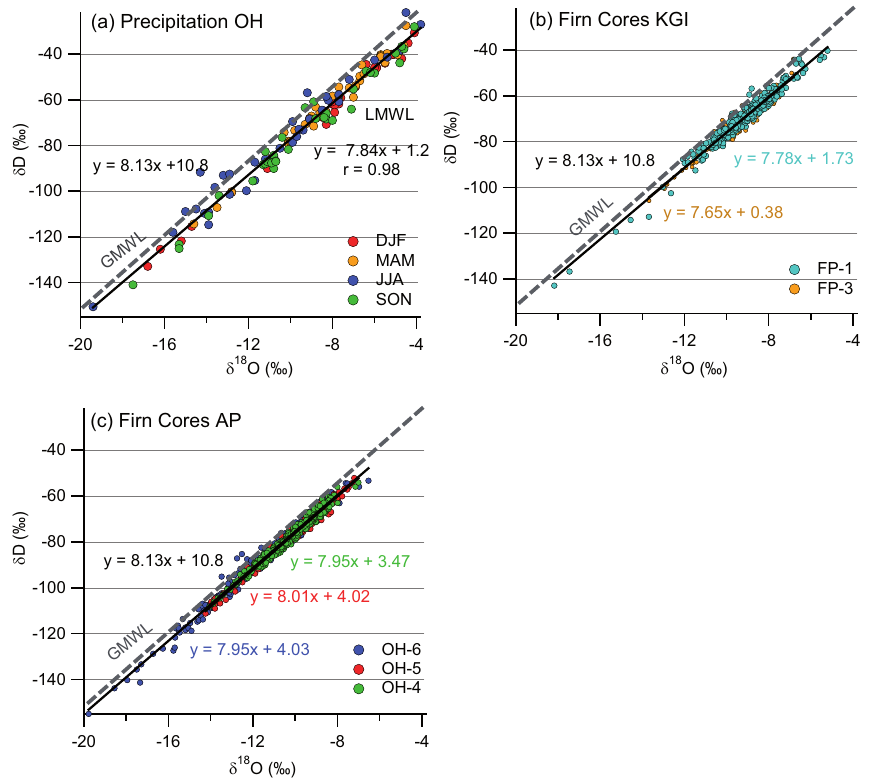
Fig. 8. Co-isotope relationships for: (a) Precipitation samples collected in O’Higgins showing the Local Meteoric Water Line (LWML) defined for this location (black line), (b) Firn cores retrieved from King George Island (FP cores) and (c) firn cores from the Antarctic Peninsula (OH). For all correlations the equation of the best linear fit is presented, additionally the Global Meteoric Water Line (GMWL) is shown for all three figures (dashed grey